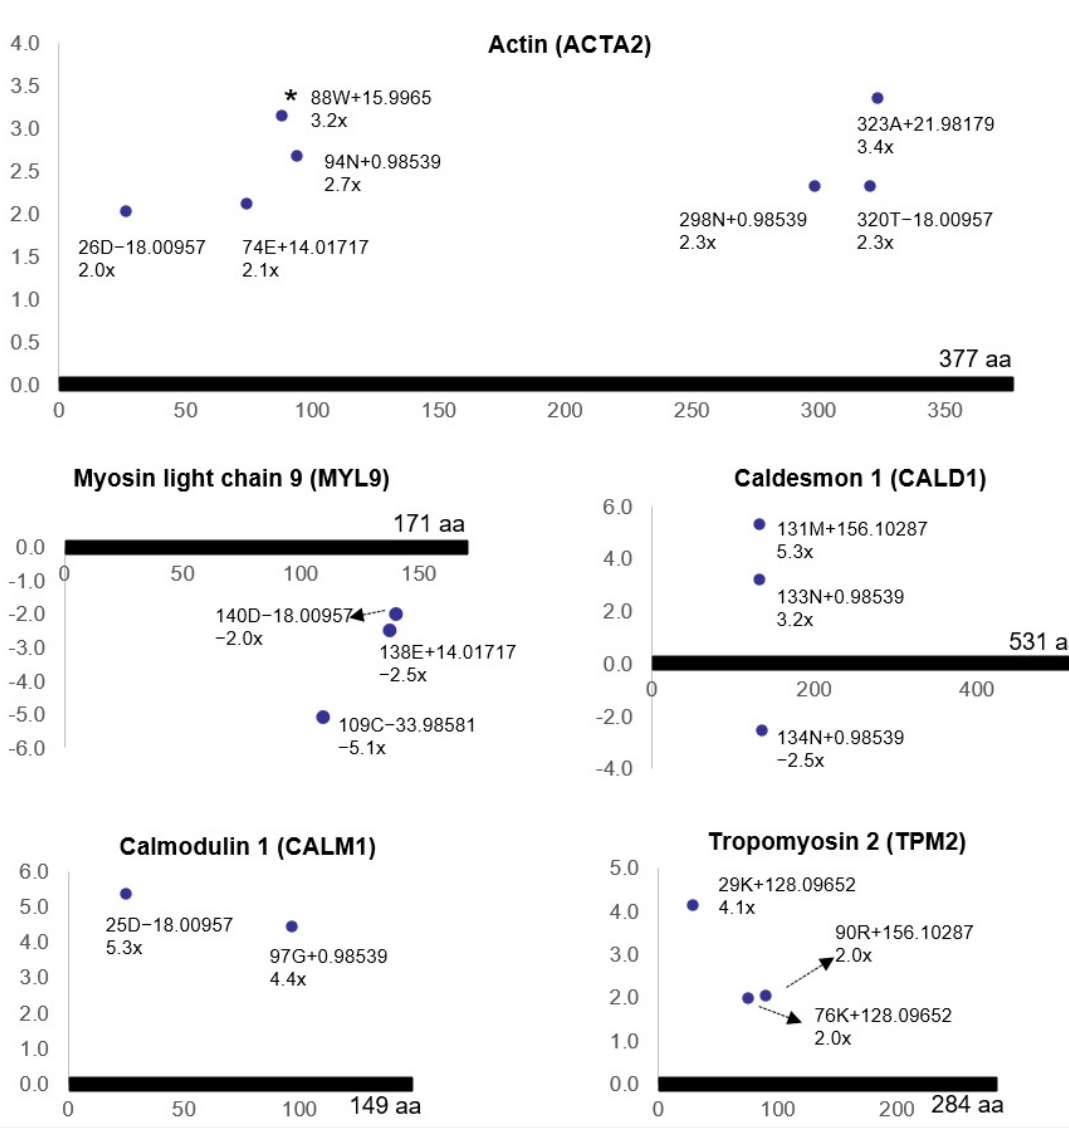
Figure 1. The modified residues of the proteins involved in smooth muscle contraction (R 2 > 0.5, ratio > 2, p < 0.05). Each dot represents an ncAA of each protein. The annotation information of each dot is as follows: modified (protein) position, modified amino acid residue, delta mass and ratio of modification. The horizontal axis represents the amino acid position of each protein; The vertical axis represents the ratio of modification (up or down). The asterisk denotes the oxidation of actin. The possible modification for each nonzero delta mass is as follows: − 18.00957: E > pyro-E, dehydration; 14.01717: methylation, D > E, N > Q, G > A, S > T, V > I/L; 15.9965: oxidation or hydroxylation, A > S, F > Y; 0.98539: deamidation, N > D, Q > E; 21.98179: sodium adduct; − 33.98581: F > L/I, C > deHA, M > P; 156.10287: addition of arginine; 128.09652: addition of lysine.